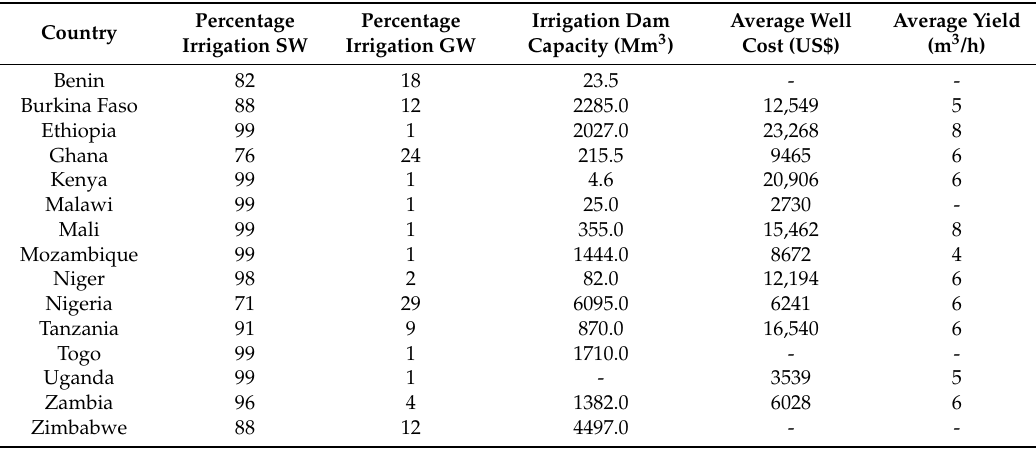
Table 5. The percentage distribution of irrigation water sources between the surface water (SW) and groundwater (GW) in each of the 15 countries, and the irrigation dam capacity (FAO) [26]; and the average well cost and average yield (Xenarios and Pavelic)